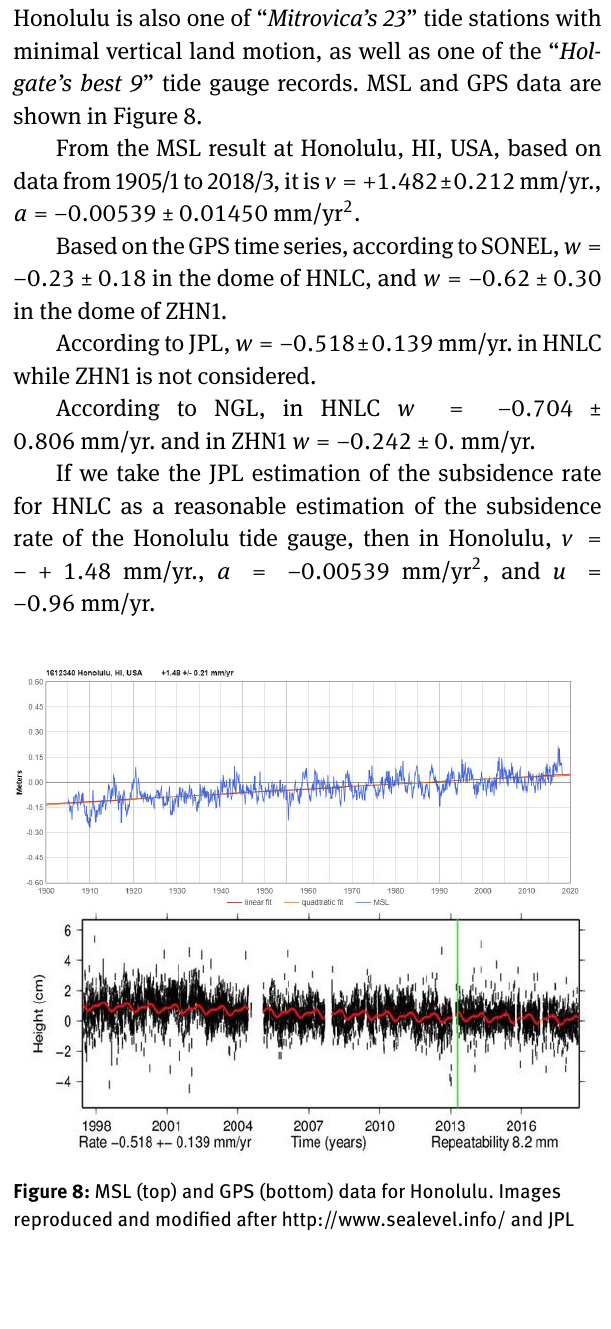
Figure 8: MSL (top) and GPS (bottom) data for Honolulu. Images reproduced and modified after http://www.sealevel.info/ and